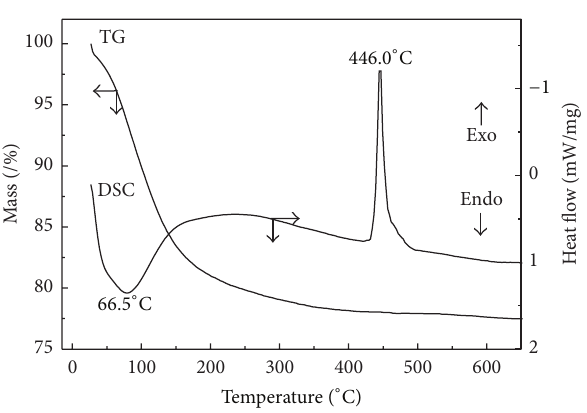
Figure 5: XPS spectra of sample (a).